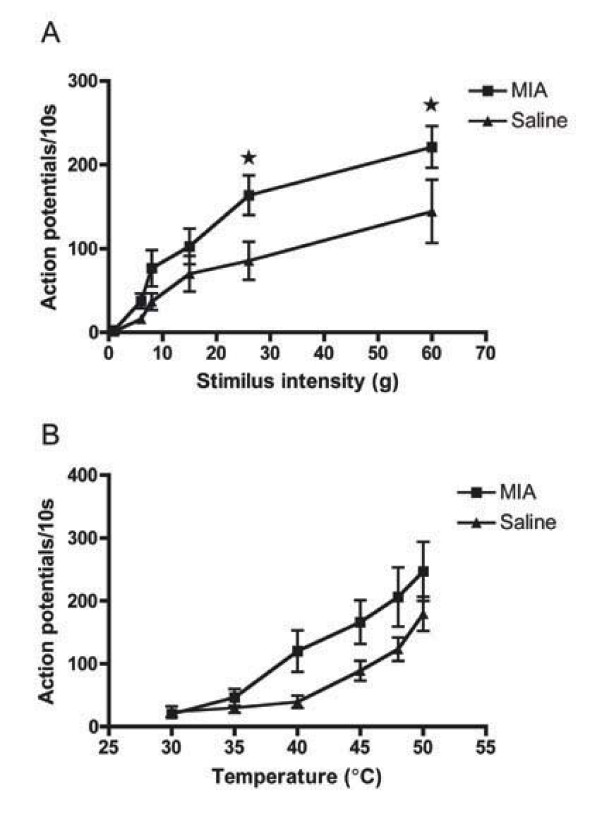
Mechanical but not thermal coding of spinal neurones is facilitated in MIA-injected animals. Stimuli were applied to the hindpaw for 10 s and responses are presented as mean ± S.E.M. (MIA, n = 12; saline, n = 13) A. Dorsal horn neurones displayed responses to mechanical stimuli in an intensity dependent manner. MIA-injected mice displayed exaggerated responses to noxious punctate mechanical stimuli * p < 0.05. B. Dorsal horn neurones displayed responses to thermal stimuli in an intensity dependent manner.